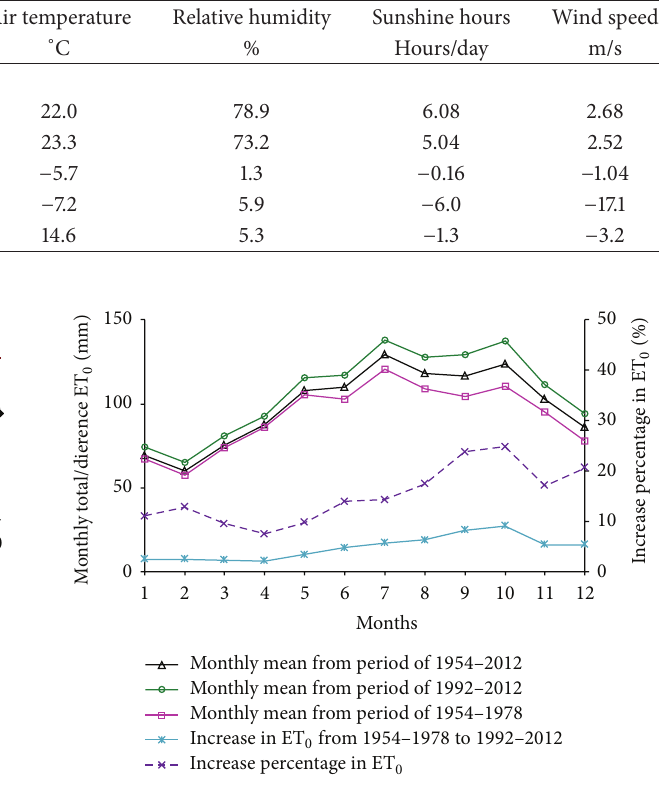
Figure 10: Yearly distribution of ET 0 averaged in the periods of 1954–1978, 1992–2012, and 1954–2012. ET 0 increase amount and the corresponding increase percentage in each month from periods of 1954–1978 to 1992–2012 were